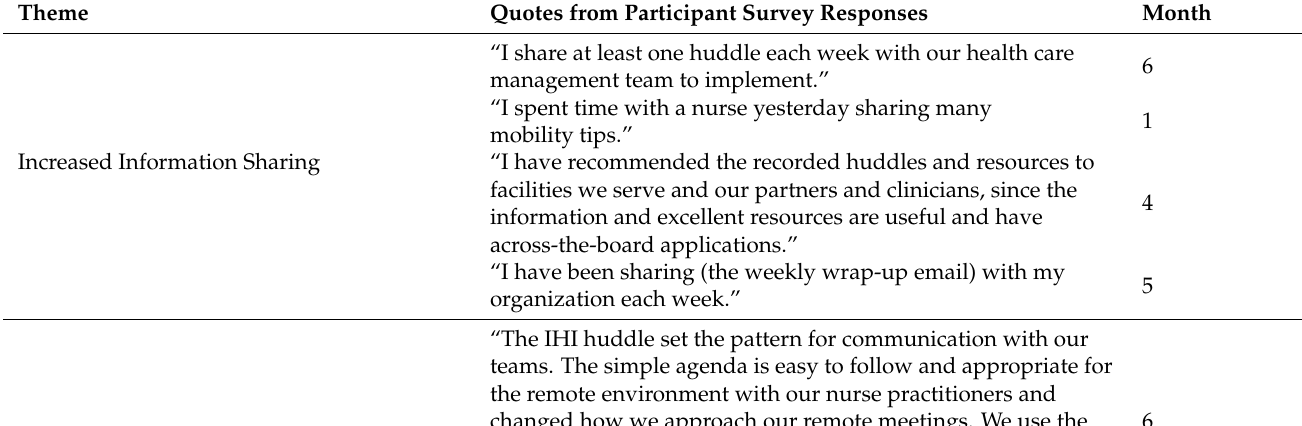
Table 5. Selection of qualitative impact results from monthly participant